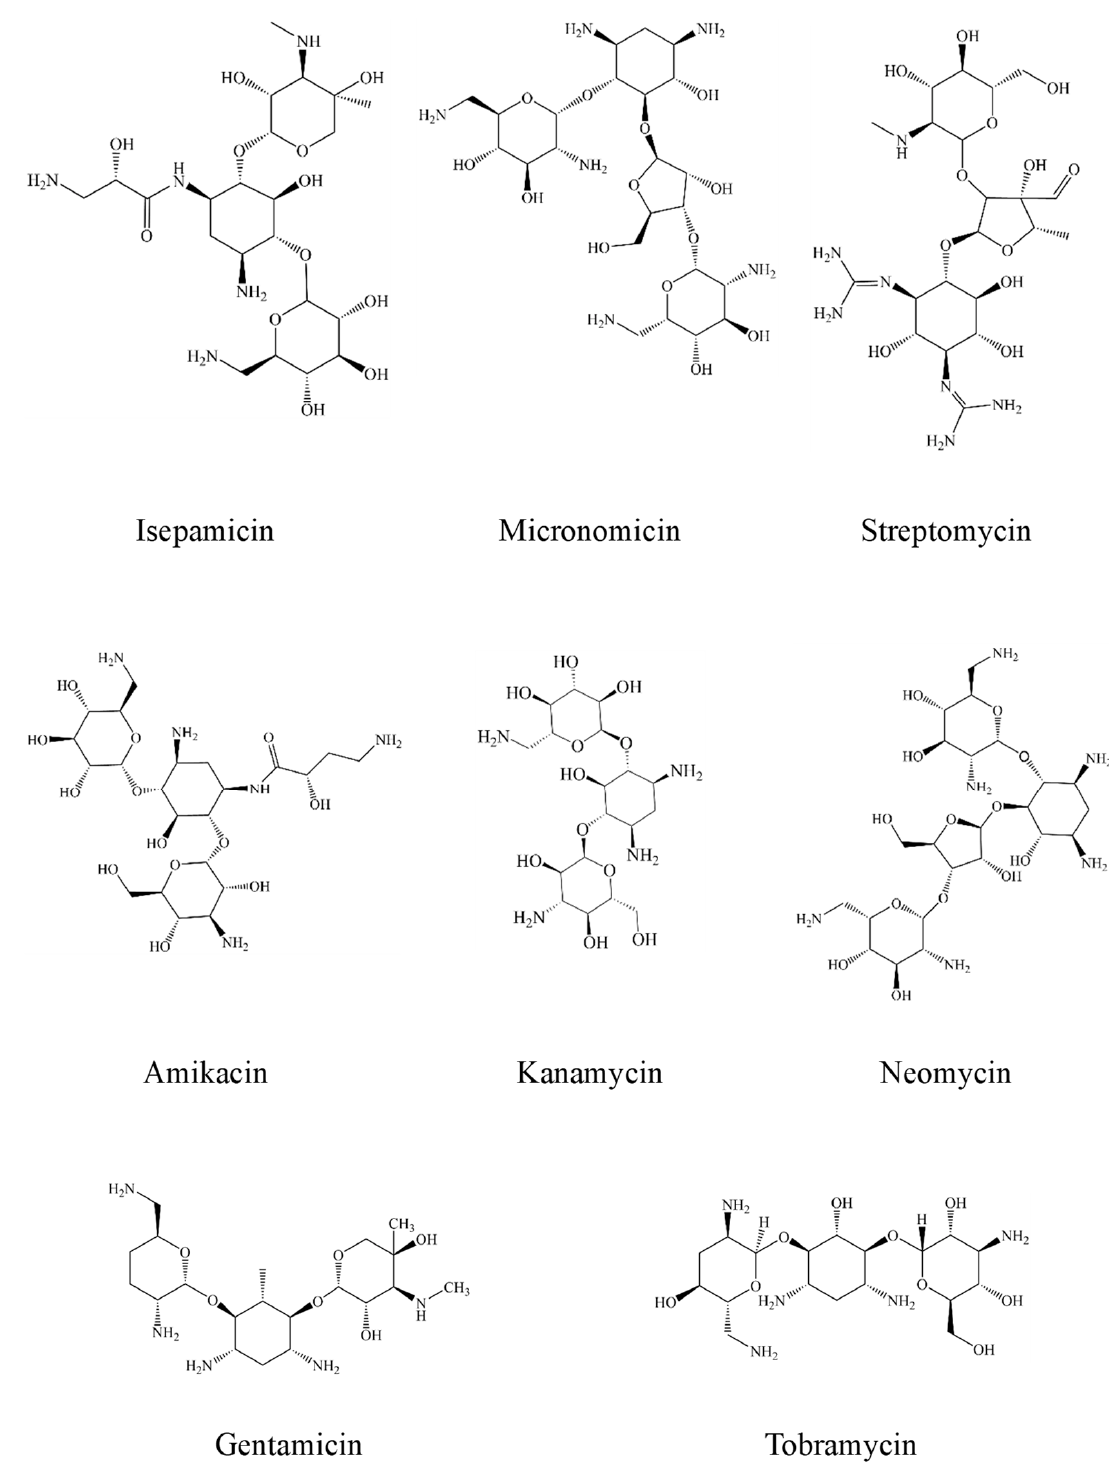
Figure 1. Chemical structure diagram of aminoglycoside